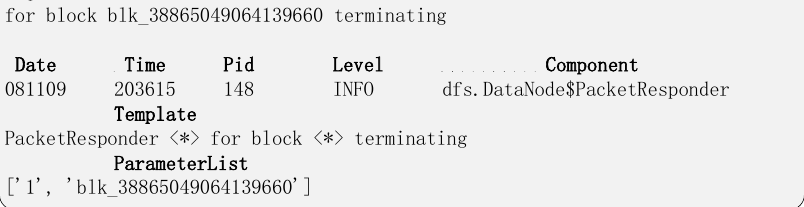
Figure 5. Components of an HDFS log. The “*” in the figure represents the variable part in the log